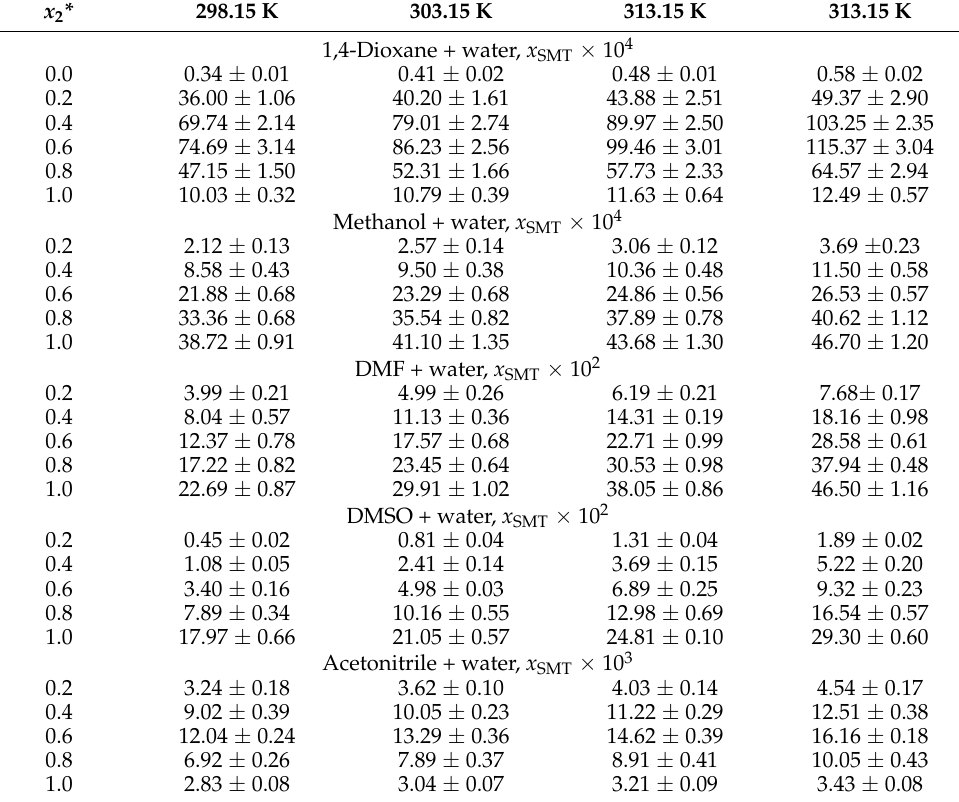
Table 2. Values of experimentally determined sulfamethizole solubility in five studied aqueous or- ganic solvents binary mixtures. The first column comprises mole fractions of organic solvent in solute free solutions. ( x 2 * represents the mole fraction of organic solvent in solute-free binary